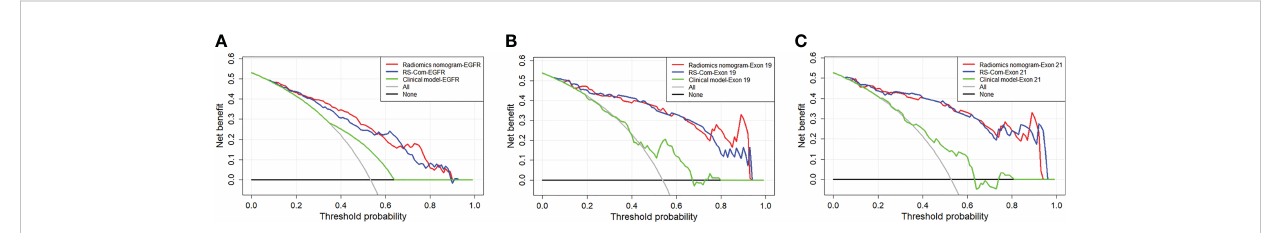
FIGURE 6 DCA curves for the developed radiomics models in the training (A) , internal validation (B) and external validation (C)